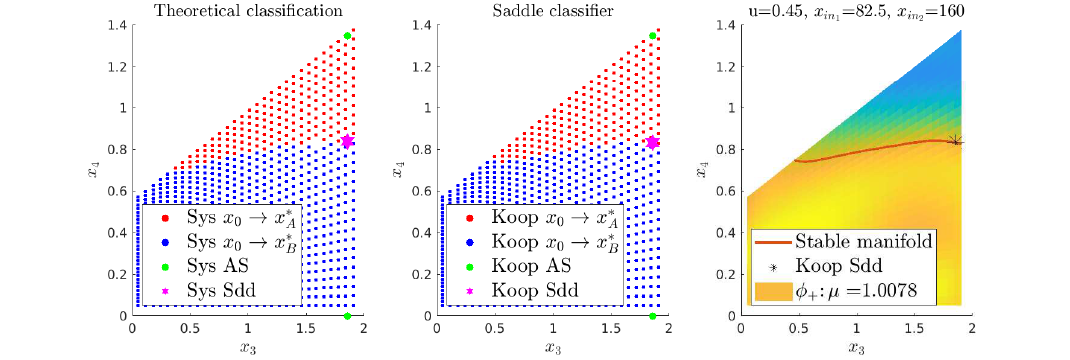
Figure 8: Theoretical, saddle based classification of initial conditions, and eigenfunction with the corresponding saddle point and stable manifold.